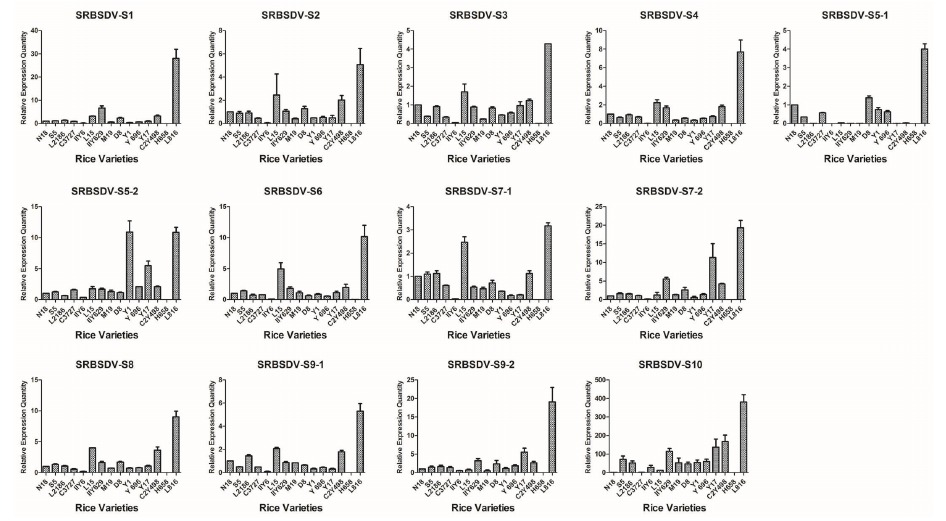
Figure 2. Map generated from the responses of 15 dual infestation rice varieties to 13 SRBSDV genomes. All rice varieties consisted of N18 (1), S5 (2), L2186 (3), C3727 (4), IIY6 (5), L15 (6), IIY629 (7), M19 (8), D8 (9), Y1 (10), Y696 (11), Y17 (12), C2Y498 (13), H658 (14), and L816 (15).